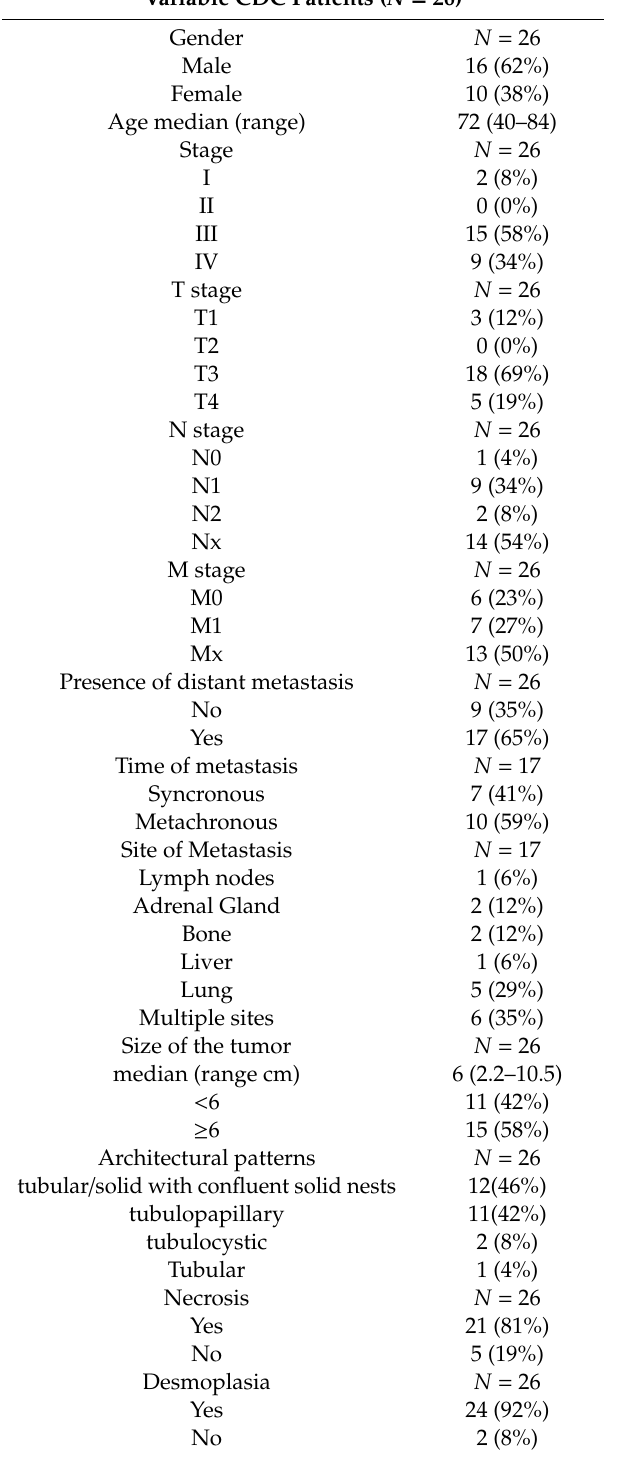
Table 1. Clinical and pathologic characteristics of collecting duct carcinoma (CDC)